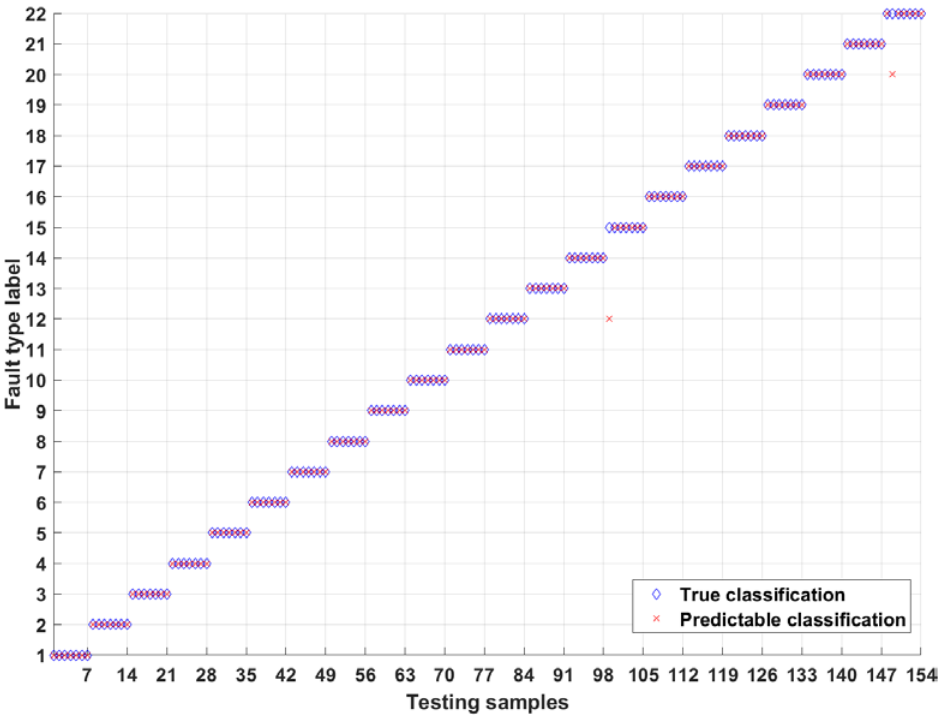
Figure 6. Diagnostic results of AFSA-SVM model.